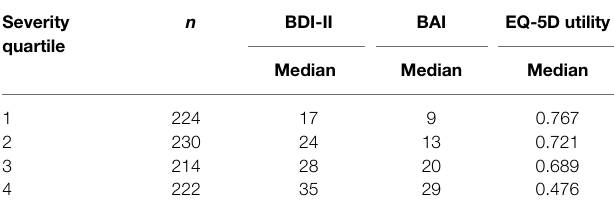
TABLE 4 | Severity of depression and anxiety symptoms by quartiles ( N =